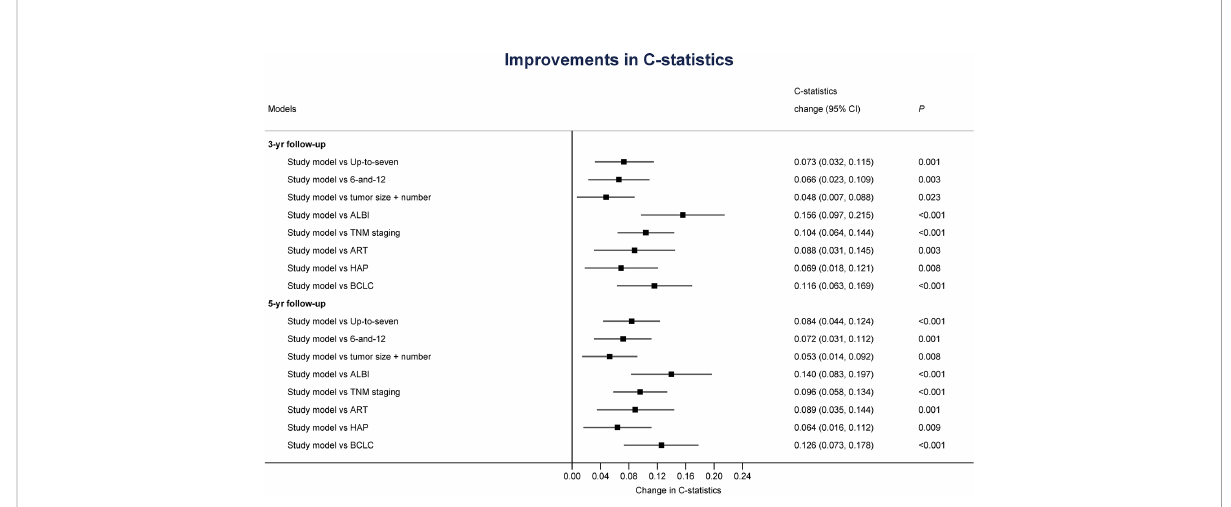
FIGURE 6 Improvements of the current scoring system in discriminative ability for overall survival as analyzed by